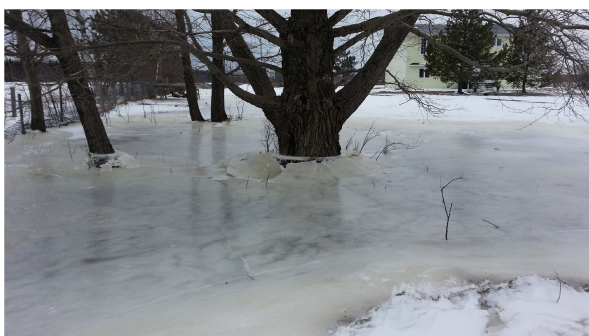
Figure 7. Frozen water after midwinter break-up and over-bank flooding on the Exploits River. Image was taken on 9 February 2013 on Beothuck Street in Badger, Newfoundland. The ring of frozen ice around the tree trunk indicates the highest water level. Hydro- metric station Exploits River at Badger (02YO013), which is not a CRID station, is ∼ 100m from this location. Image taken from Rebello